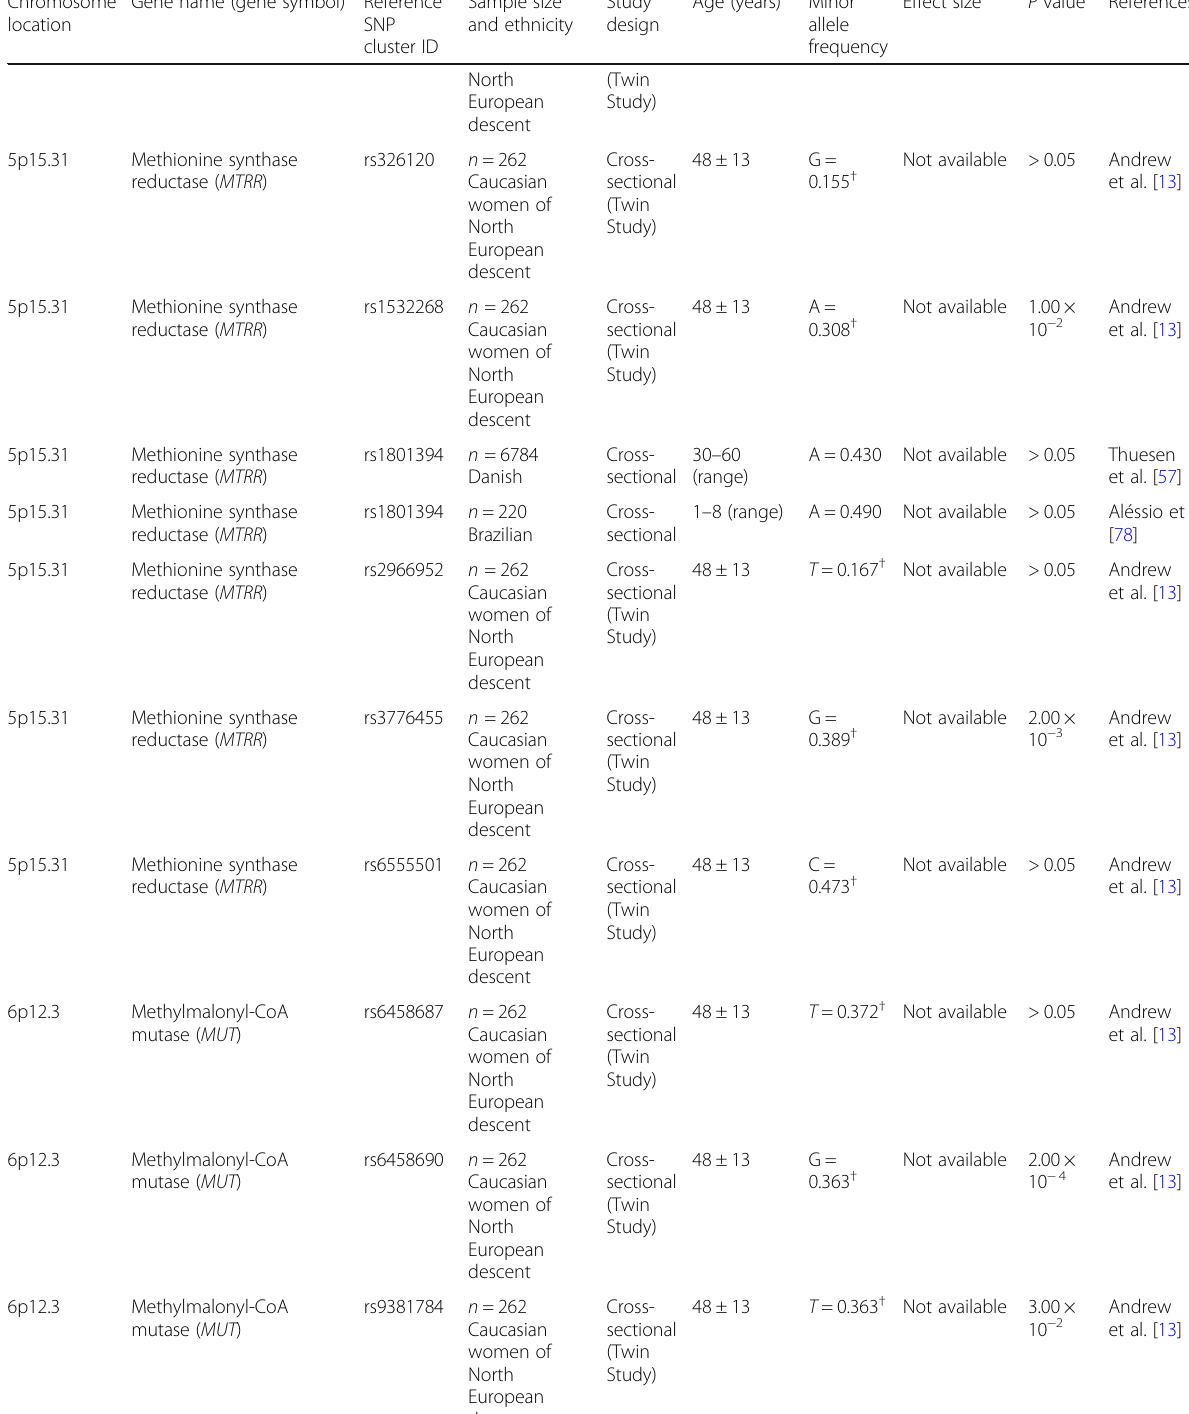
Table 2 Candidate gene association studies examining the association of SNPs with vitamin B12 concentrations. Candidate gene association studies testing the association between SNPs and vitamin B12 concentrations. The chromosome location, gene name, reference SNP cluster ID, sample size and ethnicity, study design, mean age, observed frequency of the minor allele in the population, effect size and P value are shown in the table. The order of SNPs reflects the order of the chromosome location